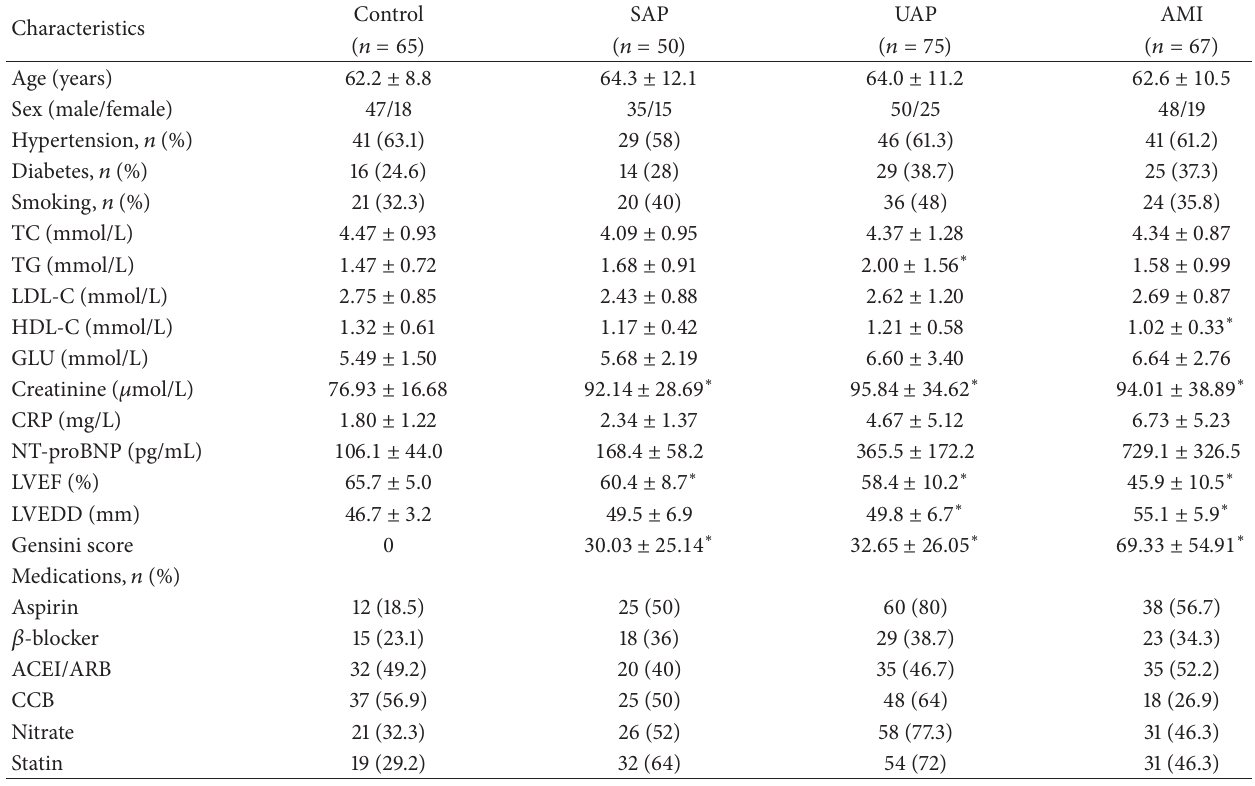
Table 1: Clinical characteristics of